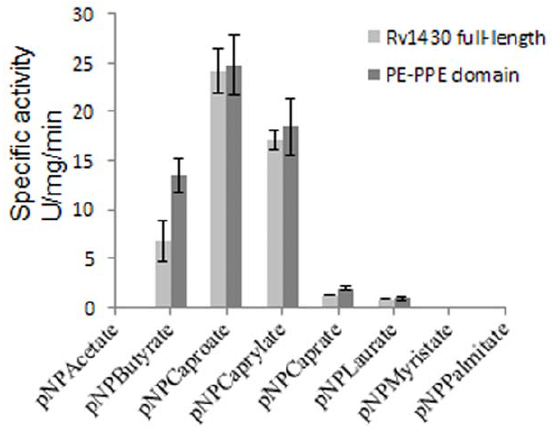
Figure 4. The specific enzyme activity of Rv1430 and PE-PPE domain towards the hydrolysis of various p -nitrophenyl ester derivatives at pH 7.0 and 37 6 C.